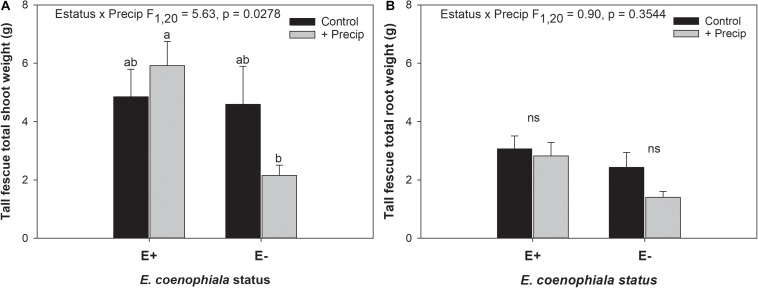
Interactive effects of endophyte status and added precipitation on total (A) shoot weight and (B) root weight in tall fescue. Bars indicate means ± 1 S.E. Within panel (A), bars sharing no common letter (a,b) indicate significant differences between means (α = 0.05), Within panel (B), lack of significant differences due to an interaction between endophyte status and added precipitation is indicated with “ns.”